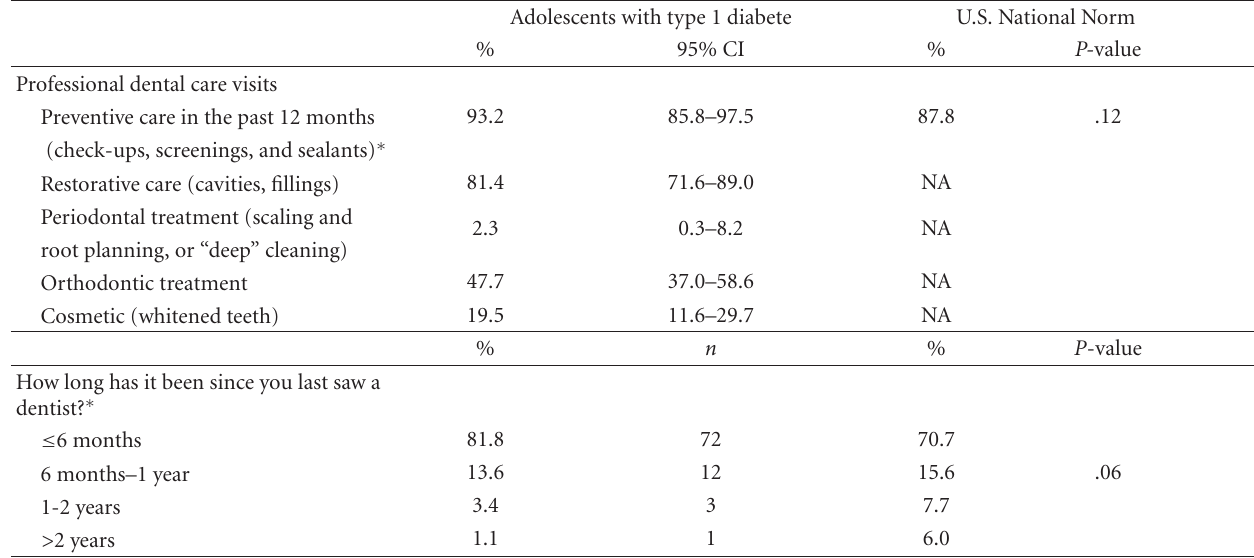
Table 3: Professional dental care. Adolescents with type 1